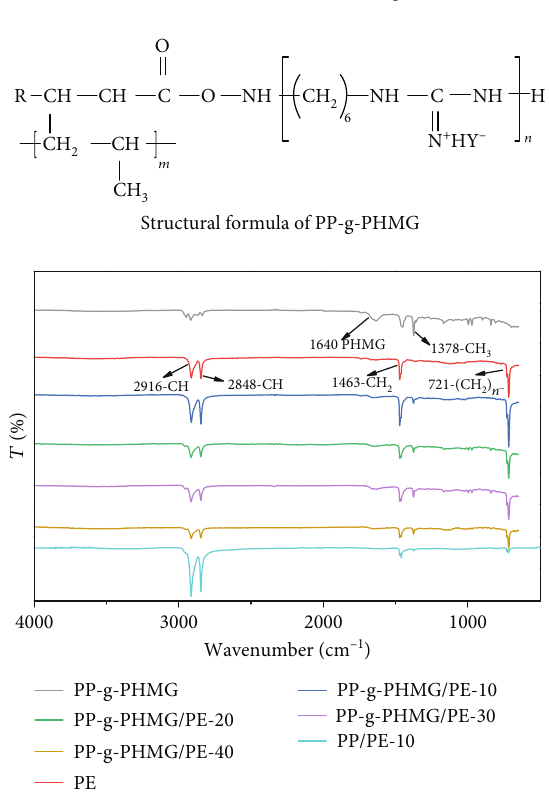
Figure 2: FT-IR spectra of PE and PP-g-PHMG/PE alloy mono fi laments.